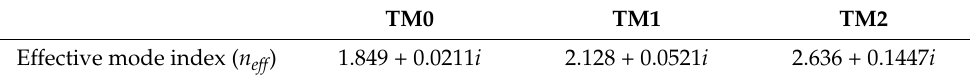
Figure 4. The calculated TM-polarized power dissipation spectra at three dipole emitter positions for ( a ) horizontal and ( b ) vertical dipole orientations. Three spectral responses of the TM modes (TM0, TM1, and TM2) are fitted to the summation of the respective Lorentzian line shape function represented in Equation (30). The spectral response caused by the near-field (NF) absorption is calculated based on Equation (28) and plotted in the evanescent spectral range of u > 1. Table 1. Effective mode indices of TM modes obtained by the boundary mode